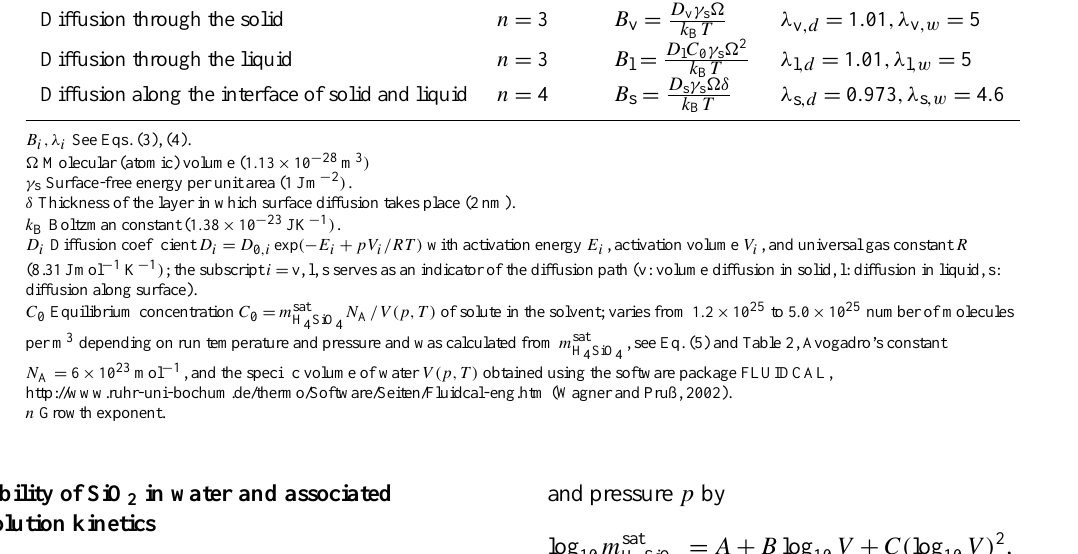
Table 1. Parameters of analytical models for grooving following the generic Eq. (3) and (4) controlled by the listed diffusion processes (see 1960; Mullins, 1957). Diffusion process Exponent B i λ i Diffusion through the solid n = 3 B v = D v γ s (cid:127) Diffusion through the liquid n = 3 B l = D l C 0 γ s (cid:127) Diffusion along the interface of solid and liquid n = 4 B s = D s γ s (cid:127)δ B i ,λ i See Eqs. (3), (4). (cid:127) Molecular (atomic) volume ( 1 . 13 × 10 − 28 m 3 ) γ s Surface-free energy per unit area (1Jm − 2 ) . δ Thickness of the layer in which surface diffusion takes place